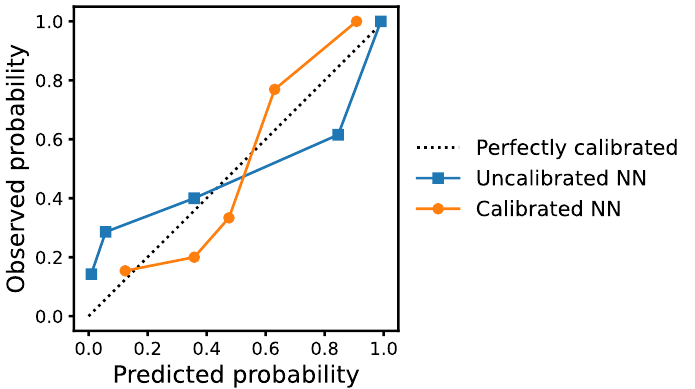
Figure 4. Reliability diagrams of the calibrated and uncalibrated neural network (NN) using isotonic regression.